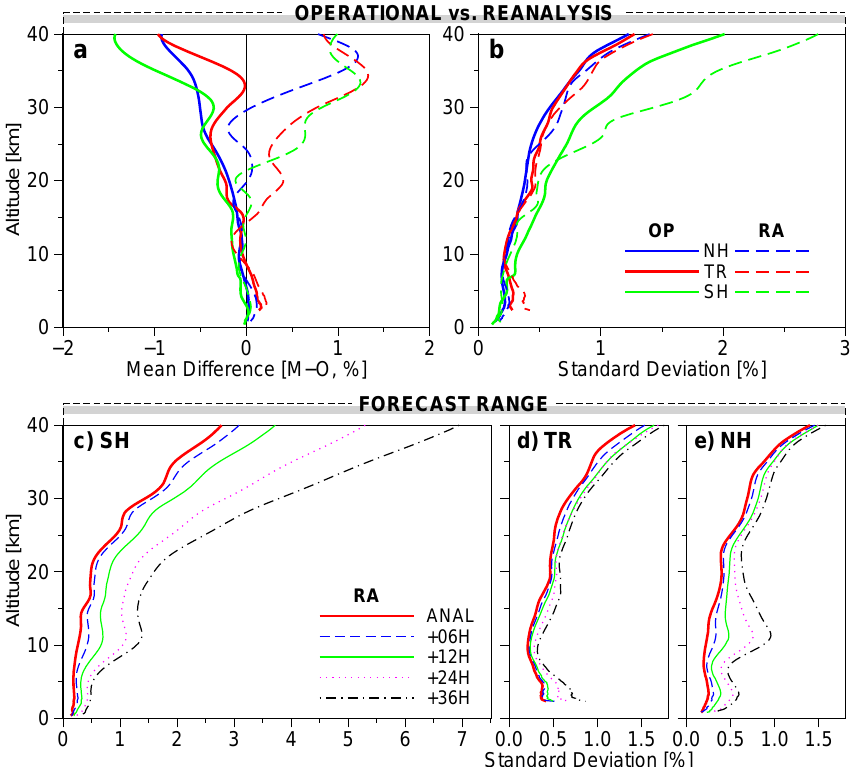
Figure 4. The (a) systematic difference and (b) standard deviation of the operational (solid) and ERA40 (dashed) analyses from RO data in three latitude bands. The standard deviation of ERA40 data from RO data for different forecast ranges over (c) southern latitudes, (d) tropics, and (e) northern latitudes. The SH and NH are south and north of the tropical zone defined as 30 ◦ S–30 ◦ N.